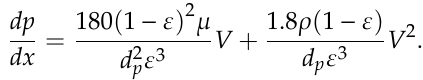
Figure4. Di ff erentregeneratorsgeometries: ( a )sphericalparticlebed, ( b )parallelflatplates, ( c )spherical microchannel matrices, and ( d ) square and rectangular microchannel Figure 4. Different regenerators geometries: ( a ) spherical particle bed, ( b ) parallel flat plates, ( c ) spherical microchannel matrices, and ( d ) square and rectangular microchannel matrices.